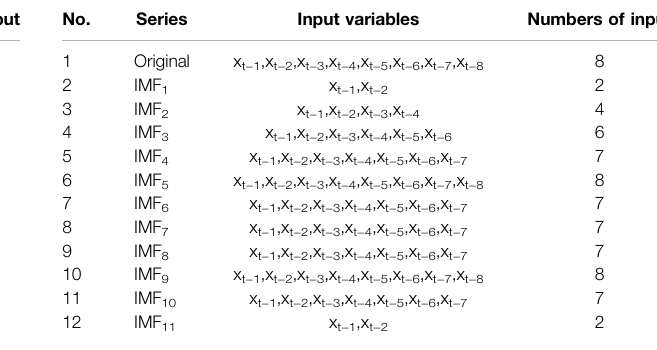
TABLE 1 | Selected input values of each series for the Guangzhao Reservoir. TABLE 2 | Selected input values of each series for the Xinfengjiang